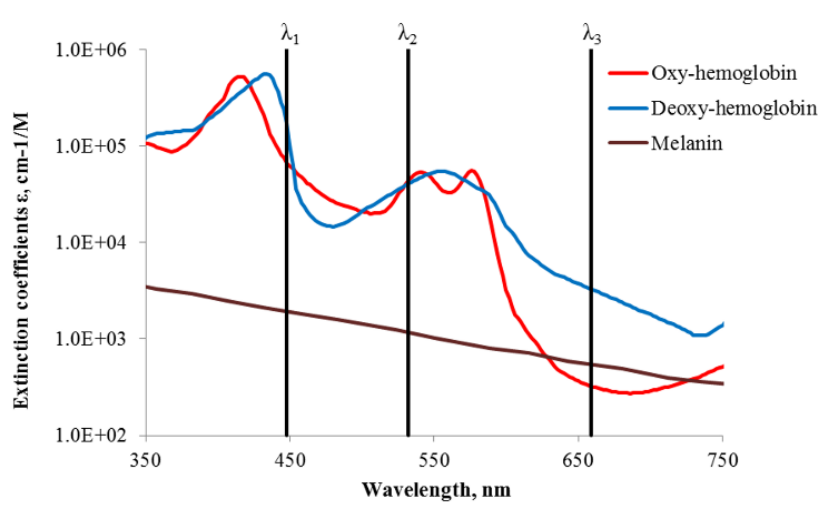
Figure 1. Absorption features of three main skin chromophores at three fixed wavelengths [24,26,27].